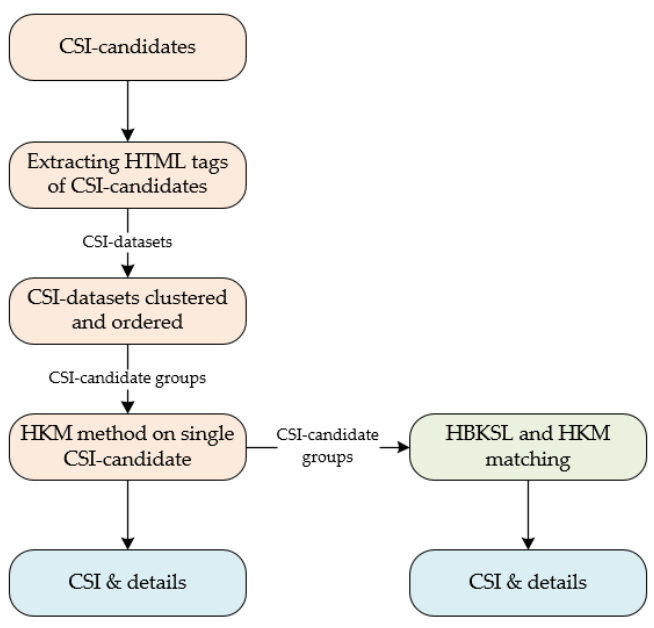
Figure 7. Clustering and extraction working flow.